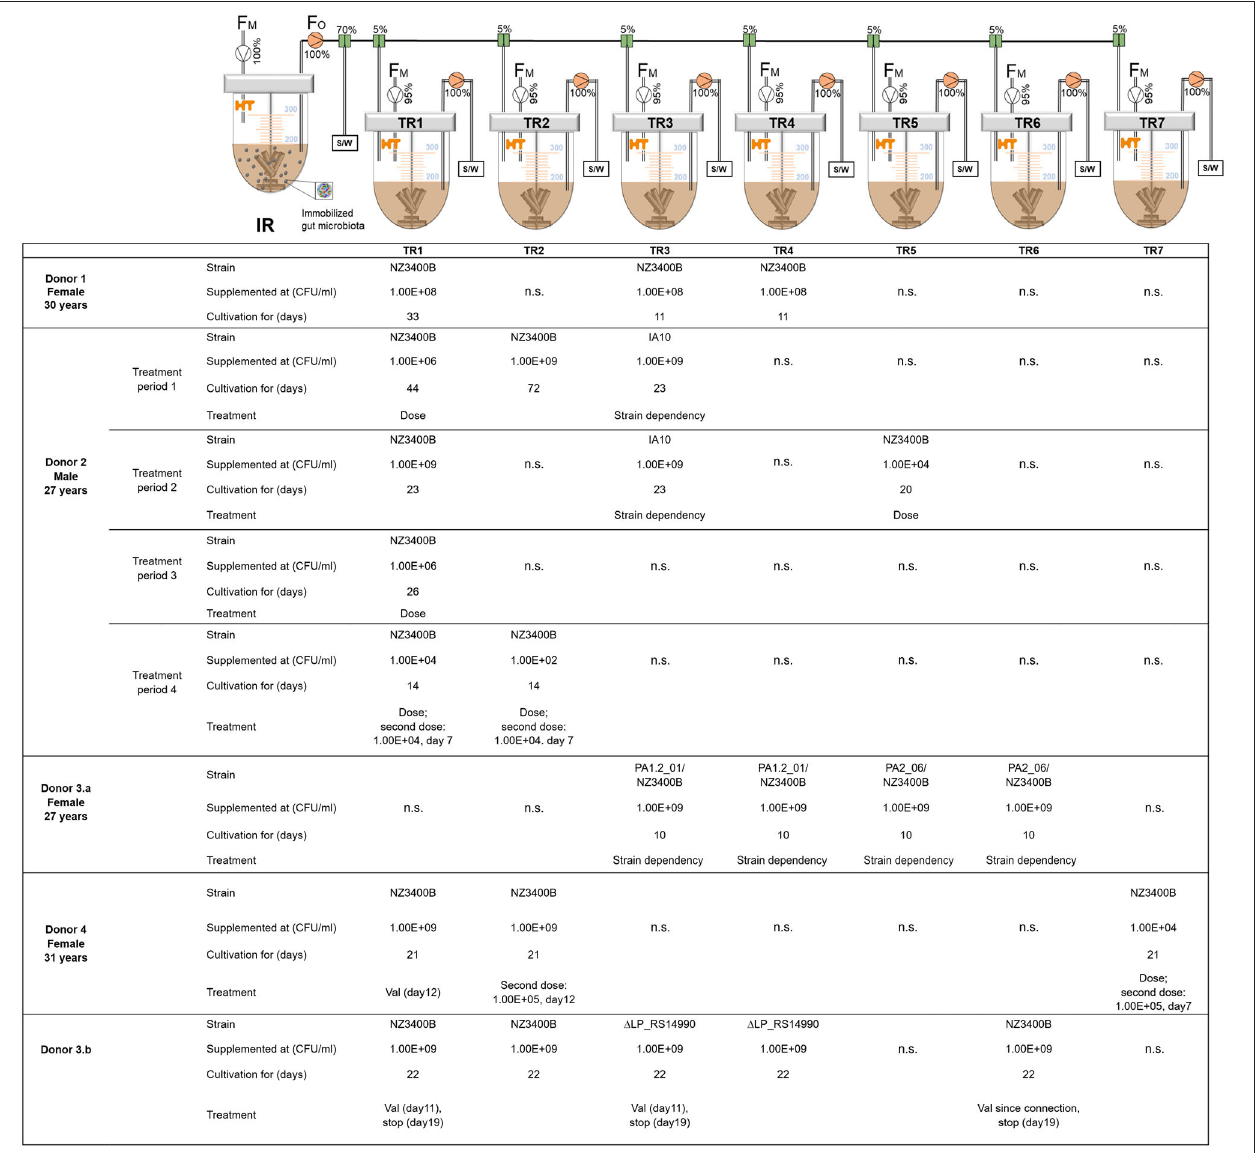
FIGURE 1 | Setup to investigate colonization of L. plantarum in human adult in vitro colonic microbiota [adapted from (Isenring et al., 2021b)]. The setup was repeated five times with the inoculum reactor (IR) inoculated with fecal microbiota obtained from four different donors (1–4) and donor 3 being repeated using two fecal samples collected 6 months apart. The IR effluent was used to continuously inoculate (5% effluent and 95% fresh medium feed rate) second-stage test reactors (TRs), providing independent replicates when supplemented in parallel with the same colonizer strain. TRs were supplemented with L. plantarum at different doses with different strains. NZ3400B, single colony isolates of NZ3400; IA10, PA1.2_01, PA2_06, L. plantarum NZ3400B mutants isolated from in vitro colonic microbiota; L. plantarum 1 LP_RS14990, LP_RS14990 gene deletion strain; F M , Inflow MacFarlane medium; F O , Reactor outflow; S/W, Sampling/Waste; Val, Valerate; n.s., reactors applied with other experimental conditions that are not included in this